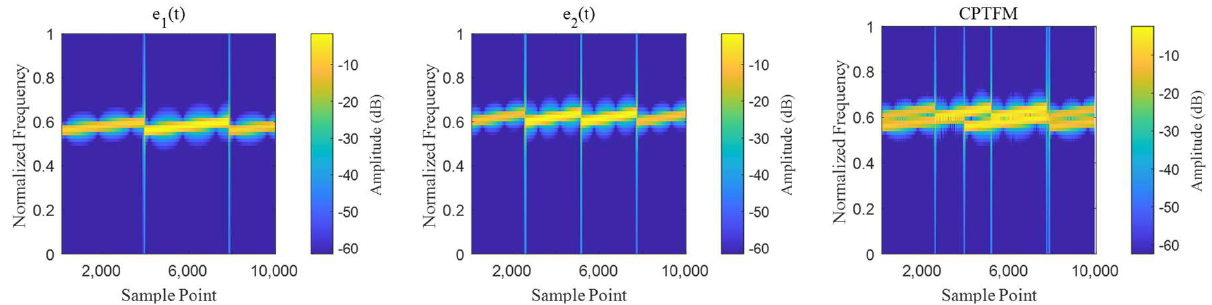
Figure 4. Time−frequency diagram of CPTFM waveform. Figure 4. Time–frequency diagram of CPTFM